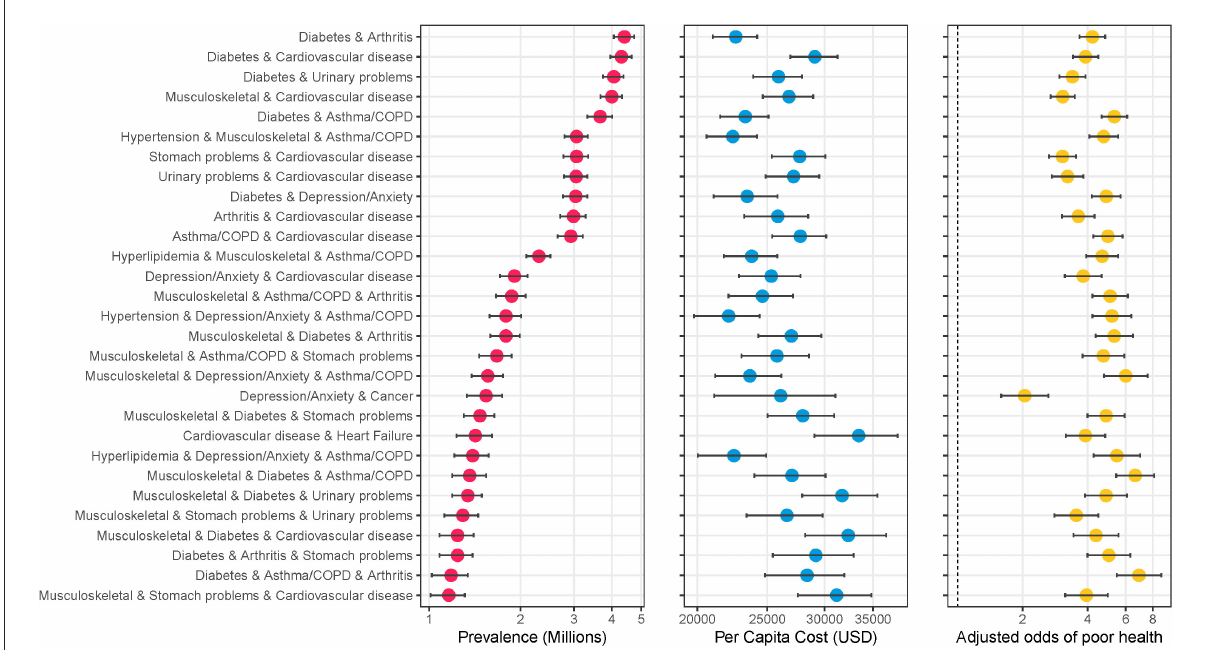
FIGURE2 Specific combinations of multimorbidity ranked highest in terms of average cost or perceived poor health. The figure shows the specific combinations of multimorbidity that ranked in the top 20 in terms of highest average cost per person or top 20 highest percentage with self-reported poor health. A total of 28 conditions met either criterion, with 12 meeting both. Data source: 2016–2019 Medical Expenditure Panel Survey (MEPS). Weighted estimates and 95% confidence intervals were calculated by applying population weights using Taylor-series methods (i.e., complex survey methods) to account for the complex sampling design of the MEPS. Weighted estimates have been annualized by taking the average over the 4-year study period. Adjusted odds ratios were calculated using log-binomial models adjusting for age, race, and sex, and Taylor-series methods for standard errors. X-axes are on the logarithmic scale, and results are sorted by